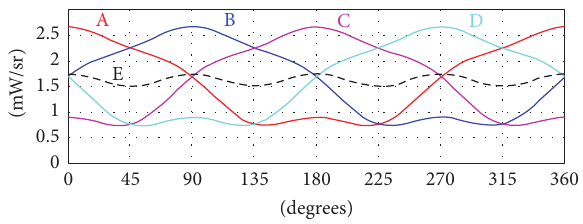
Figure 14: Reception patterns of the user ports, at 800 MHz, in the plane 𝜃 = 𝜋/2 , versus the azimuth angle 𝜑 : the pattern of user port 1 is curve A; the pattern of user port 2 is curve B; the pattern of user port 3 is curve C; the pattern of user port 4 is curve D; and the average of curves A to D is curve